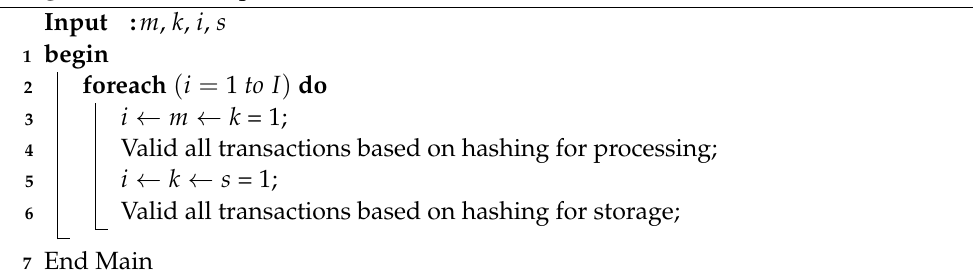
Algorithm 2 Partial proof of validation